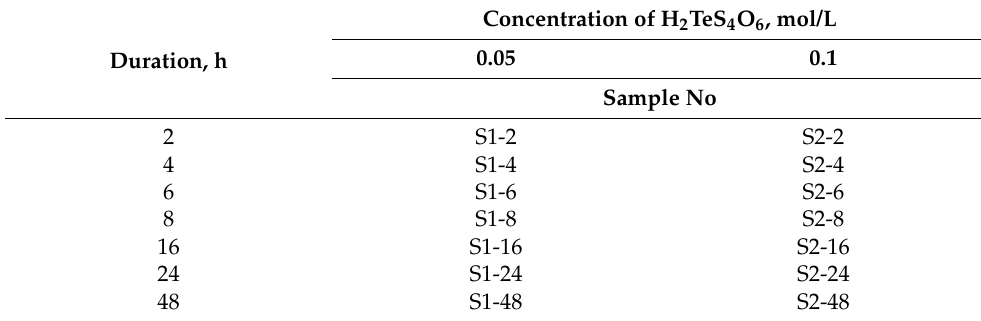
Table 2. Duration of chalcogenization of PA 6 films at 25 °C and sample labelling.